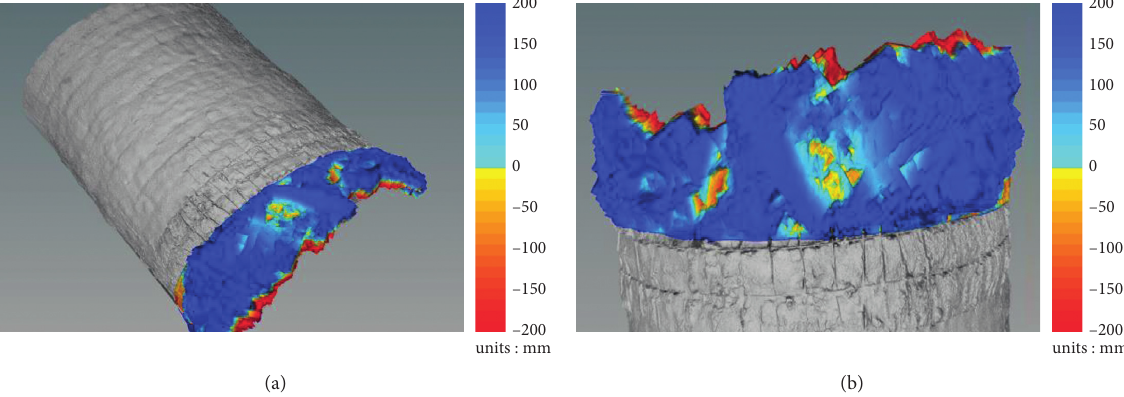
Figure 12: The tunnel overbreak and underbreak scanning. (a) Side view. (b) Front view.